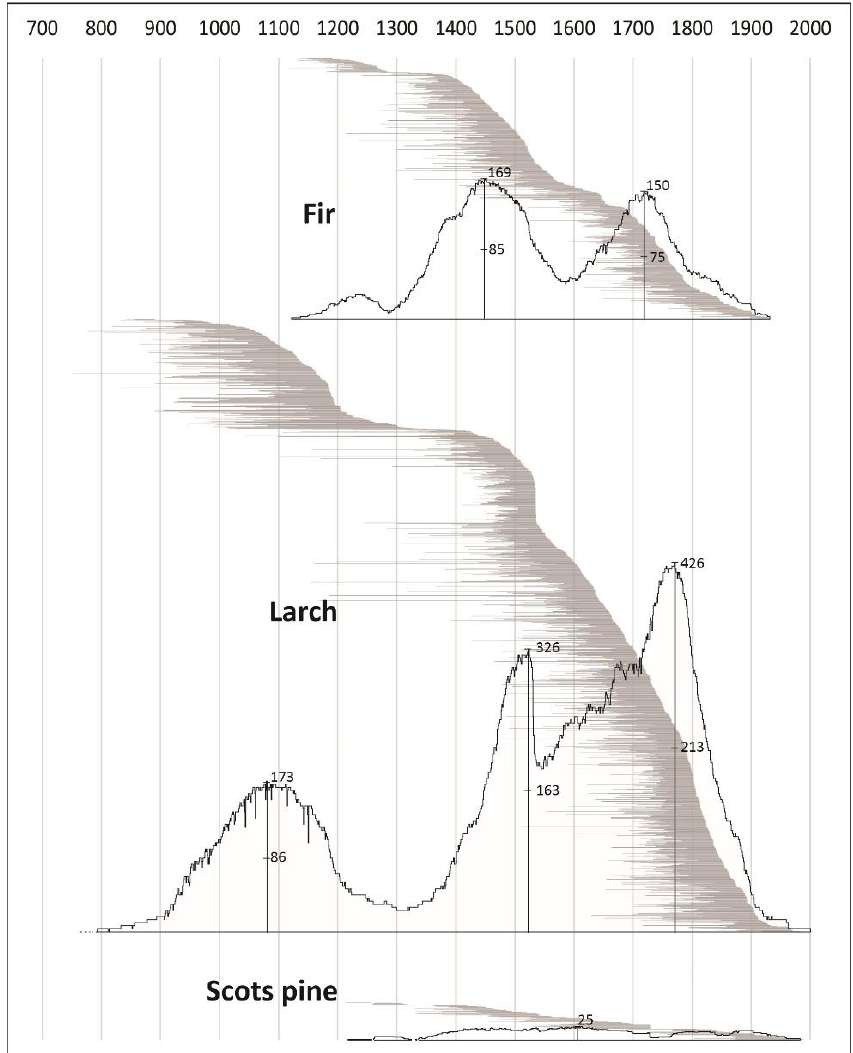
Figure 2. Block diagram of the 2345 individual archaeological series of dated fir, larch and Scots pine, arranged according to the felling dates. Each horizontal bar corresponds to a timber. Their coverings over time (number of rings available per year) are shown on top.